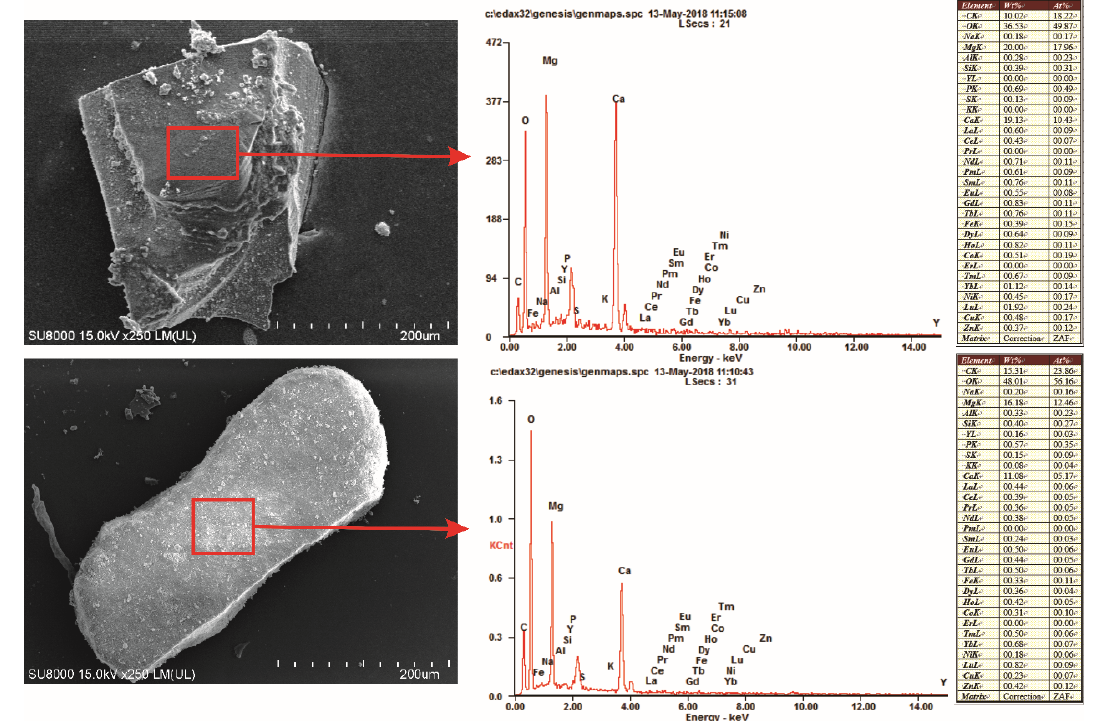
Figure 2. The microstructure and composition of dolomite using SEM-EDS analyses.